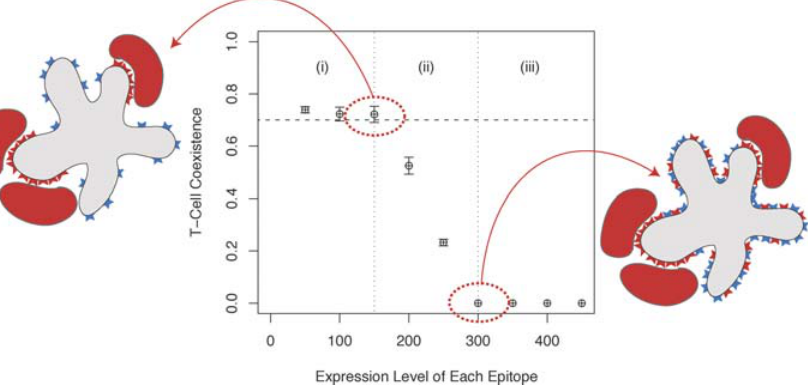
Figure 3. The Effect of the per-APC Epitope Expression Level on T Cell Coexistence Shown is the mean 6 standard deviation of three replicate simulations. The black dashed line indicates the ratio of epitope affinities of the subdominant and the immunodominant T cell specificity, which were set to 0.07 and 0.1, respectively. All other parameter settings are listed in Table 1. Left and right of the plot are illustrations of an APC with low (150 copies) and high (300 copies) per-APC epitope expression levels, respectively. In the illustrations, three T cells of the immunodominant specificity are conjugated with the APC. For low epitope expression levels this leads to a situation in which the remaining space on the APC only presents the subdominant epitope, while for high epitope expression levels the remaining space presents both epitope specificities. DOI: